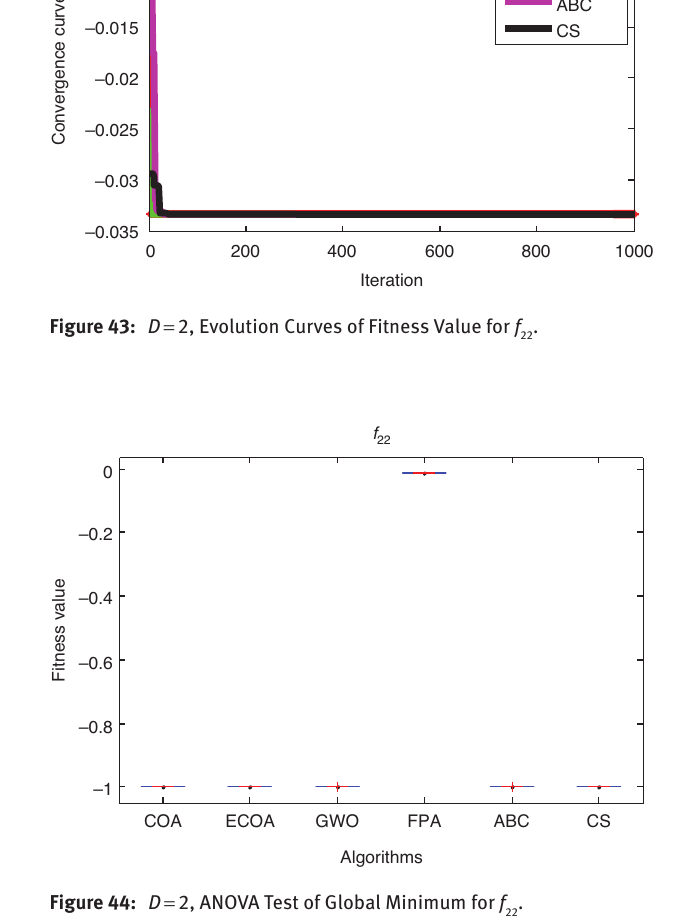
Figure 44: D = 2, ANOVA Test of Global Minimum for f